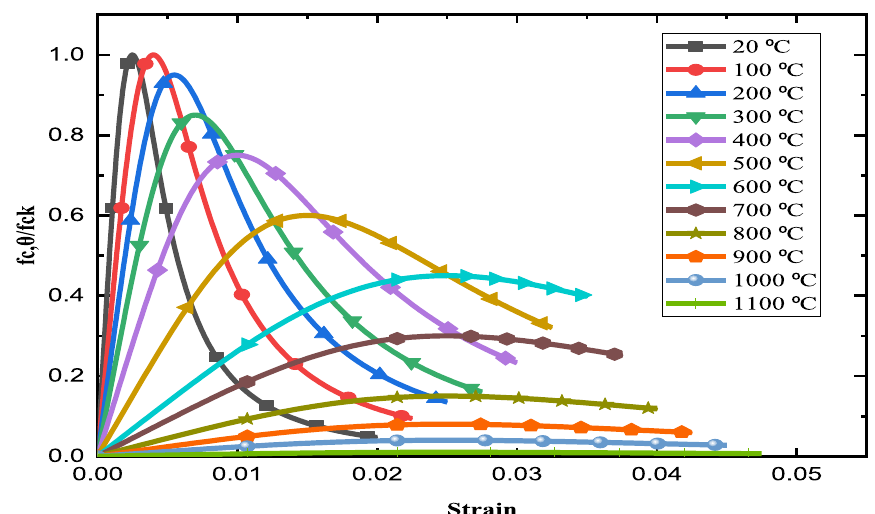
Fig. 15 Stress-strain relationships of concrete under uniaxial compression at elevated temperatures